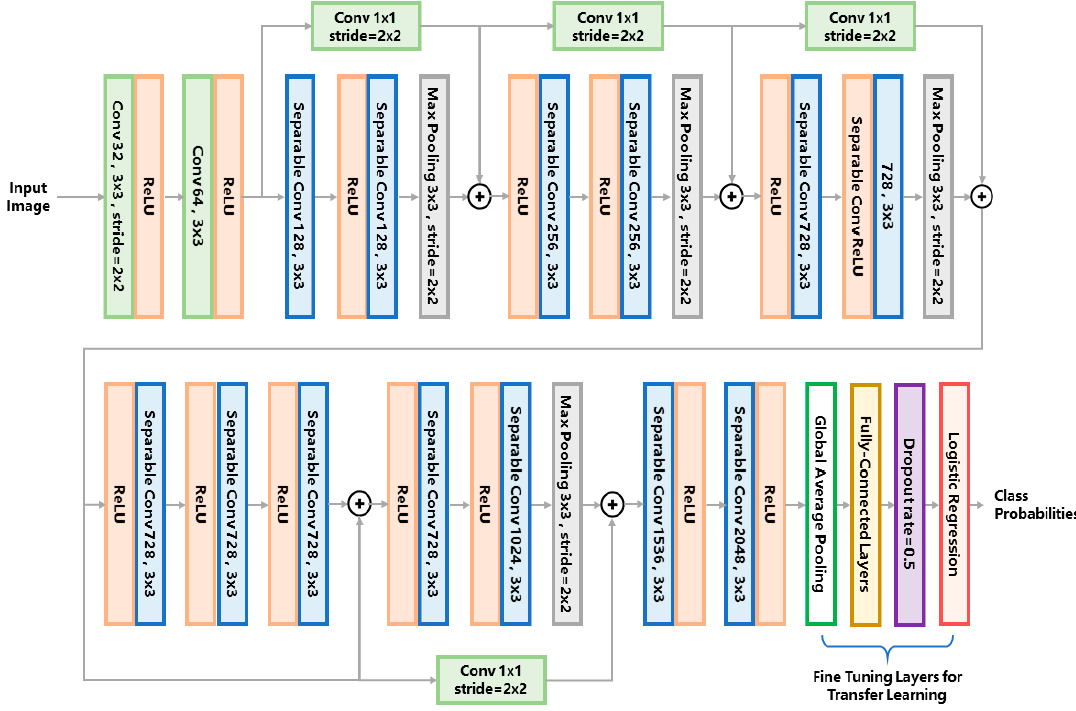
Figure 3. The classifier network architecture used in this study. The abbreviations ‘conv’ and ‘ReLU’ stands for ‘convolution kernel’ and ‘rectified linear unit’, respectively.